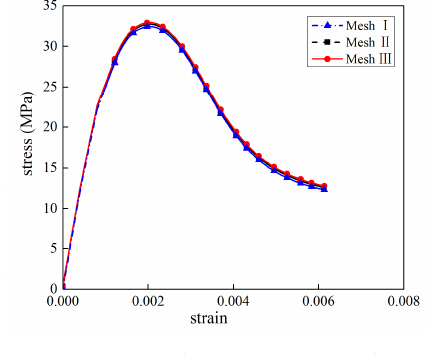
Figure 19. Mesh convergence results. Table 6. Stress statistics and relative error for different meshes on KP1.